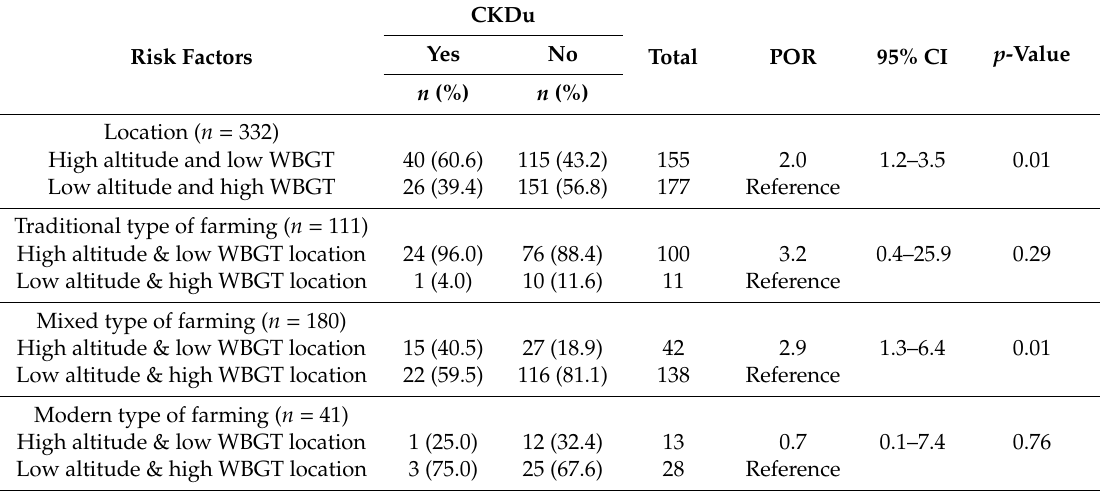
Table 5. CKDu among male farmers * according to farm location in West Java and stratified by type of farming.